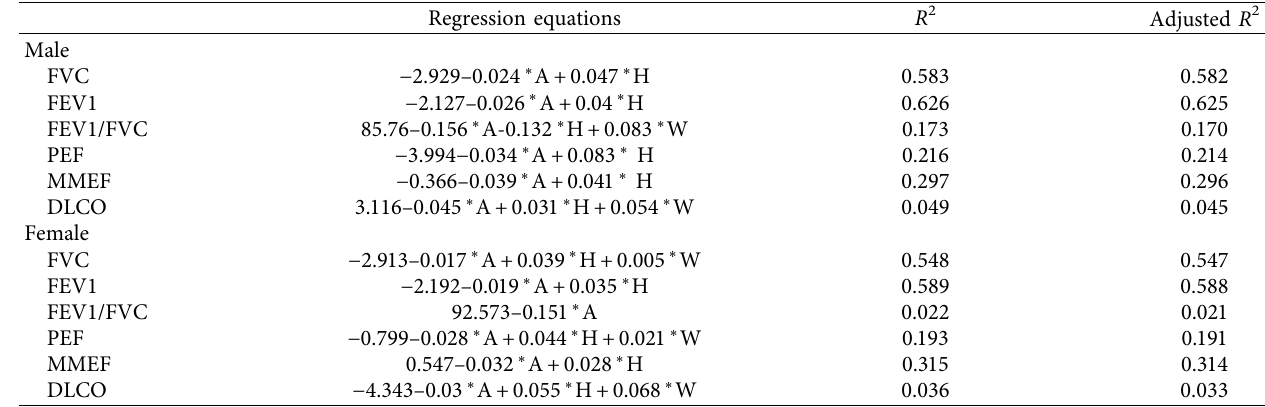
Table 4: Predictive equations of lung function.